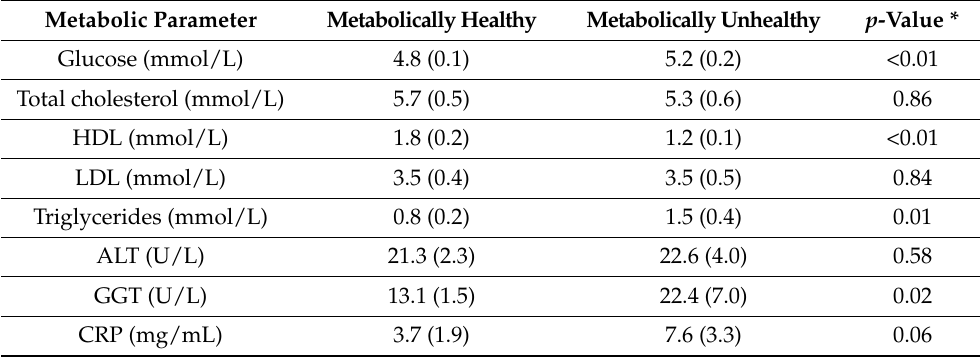
Table 5. Metabolic characteristics of metabolically healthy ( n = 14) and metabolically unhealthy ( n = 14) subjects after an acetylsalicylic acid